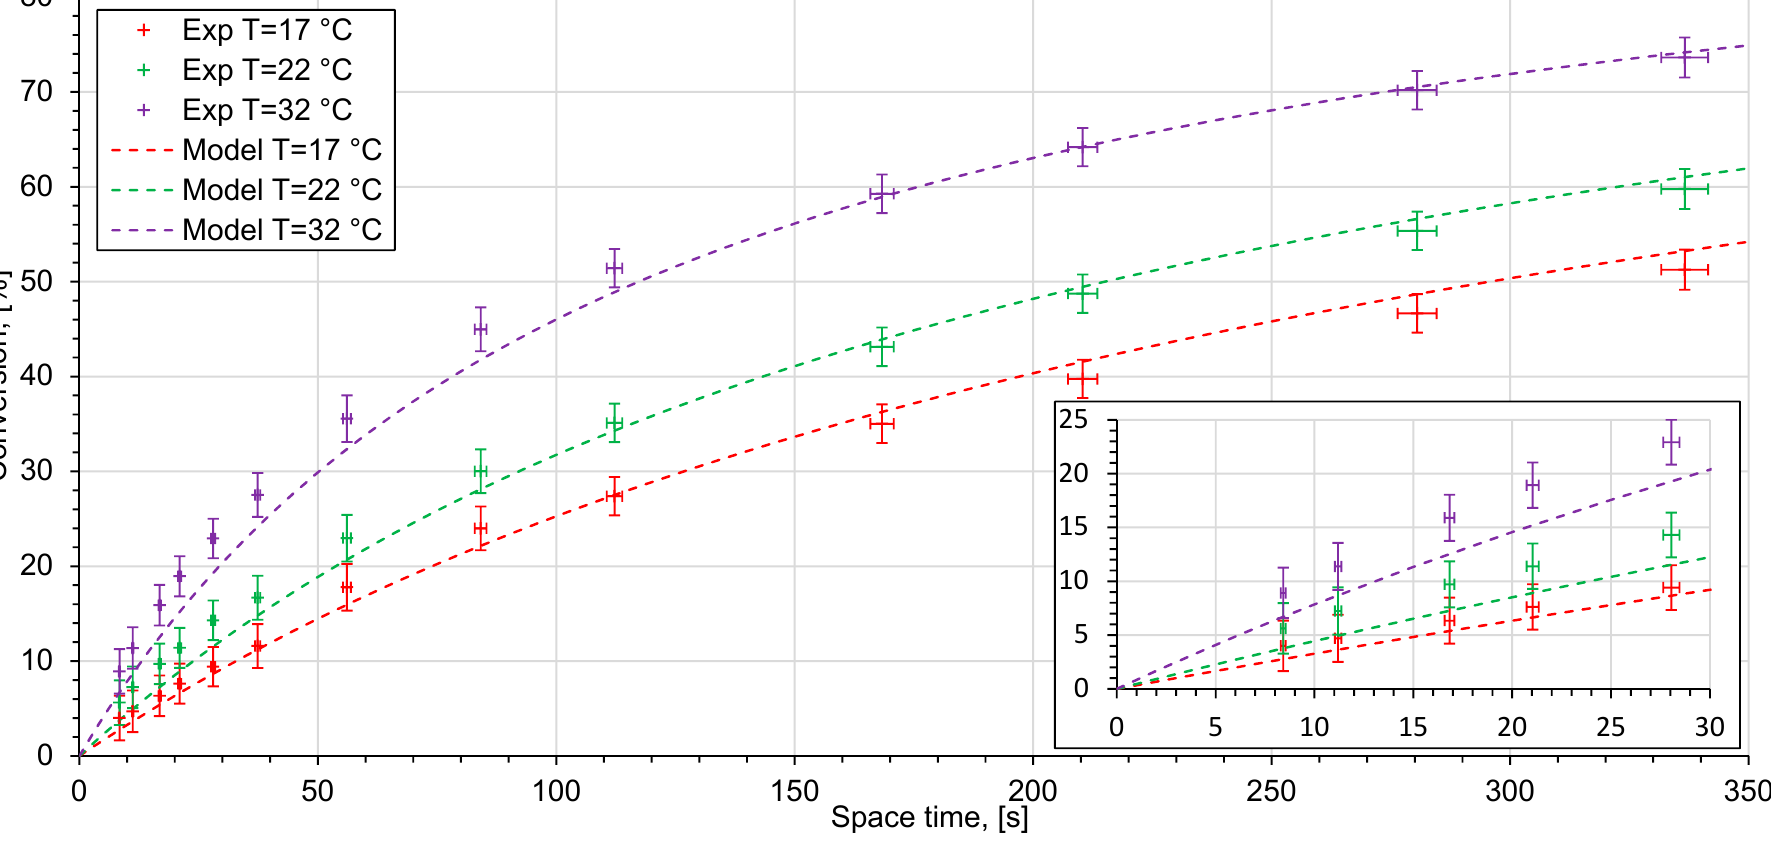
Figure 8. Experimental data (crosses) and kinetic model (dashed lines) at different temperatures in the reactor system with an interdigital microreactor.